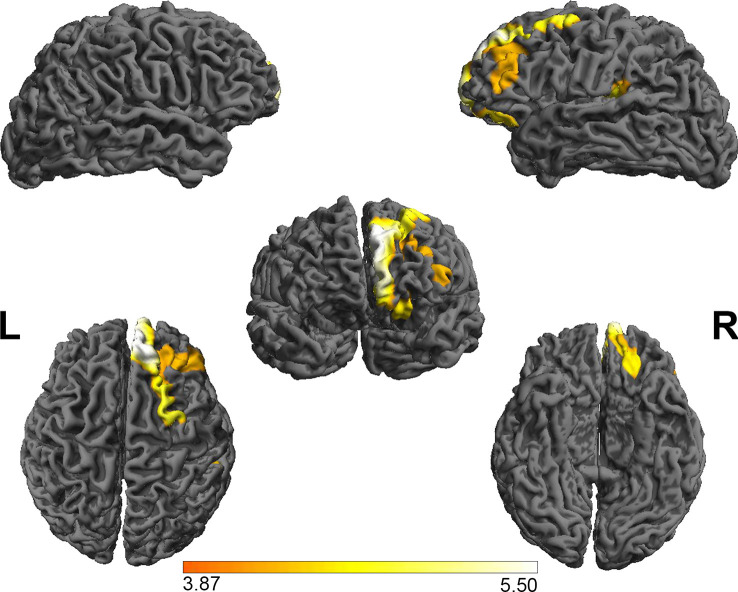
The group differences in the gyrification index between PE patients and NCs. The results showed that the gyrification index in the right OFC and the right nucleus accumbens in the PE group was greater than in the NC group. FWE-corrected, p < 0.05. OFC, orbital frontal cortex.